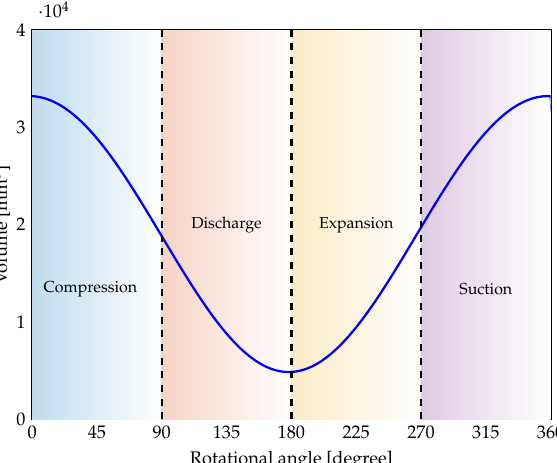
Figure 3. The volume change based on the rotational angle of the compressor for each compression, discharge, expansion and suction.